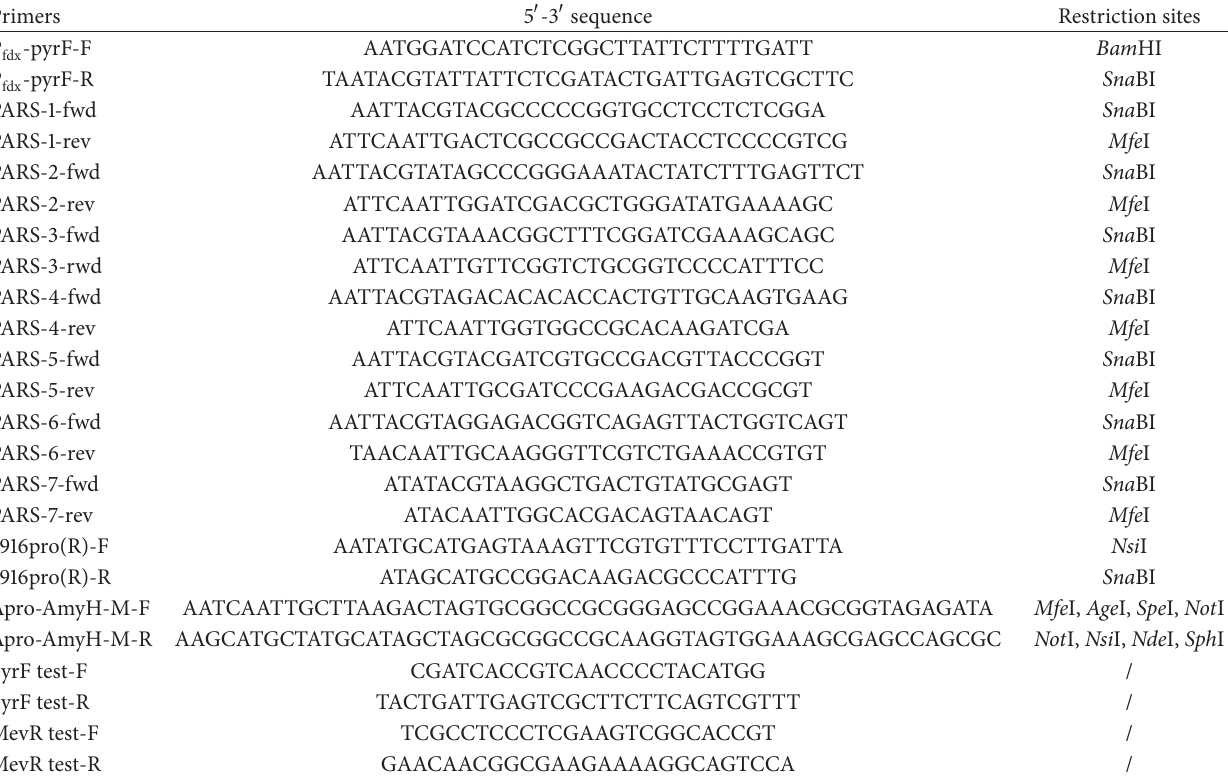
Table 2: Primers used in this